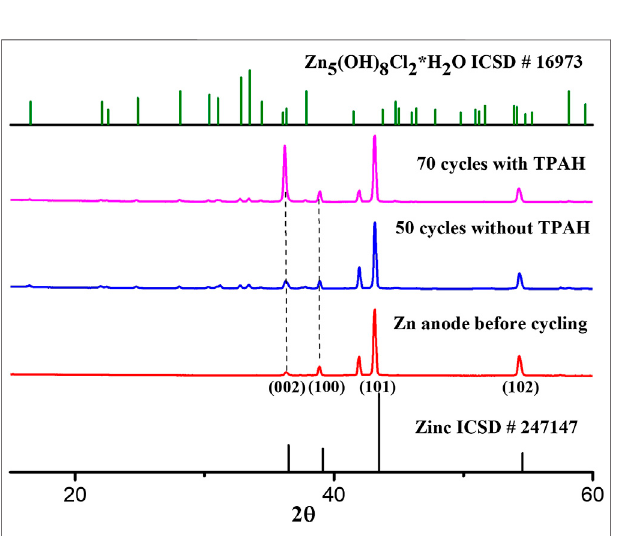
Frontiers in Energy Research |